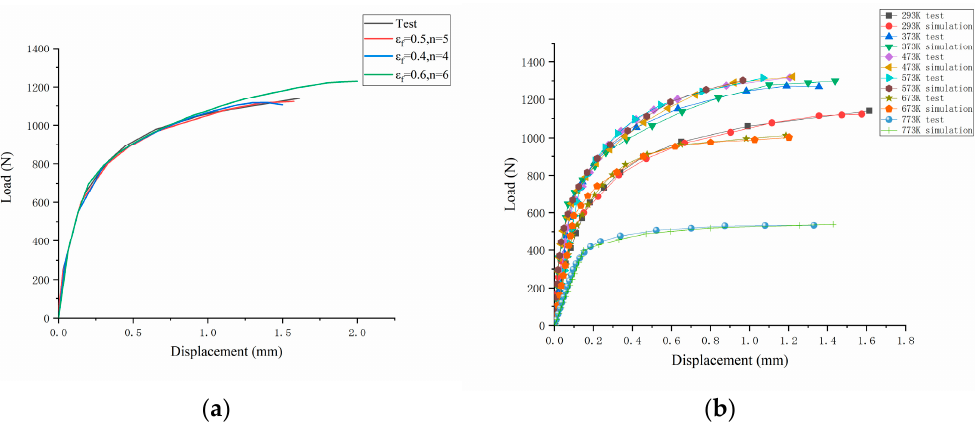
Figure 10. ( a ) Numerical simulation diagram of shear damage calibrations and ( b ) comparison of load–displacement curves of 0°shear specimen at different temperatures. load–displacement curves of 0 ◦ shear specimen at different